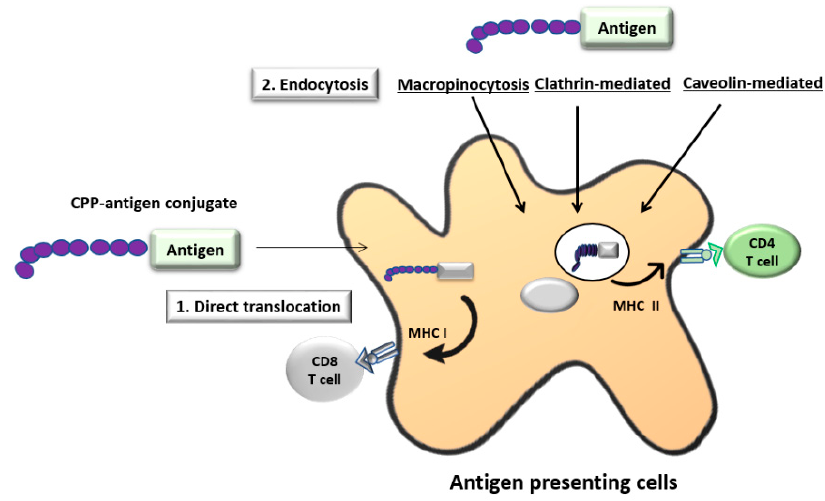
Figure 5. Illustration of the cell-penetrating peptide (CPP) delivery system. CPP are cationic peptides.